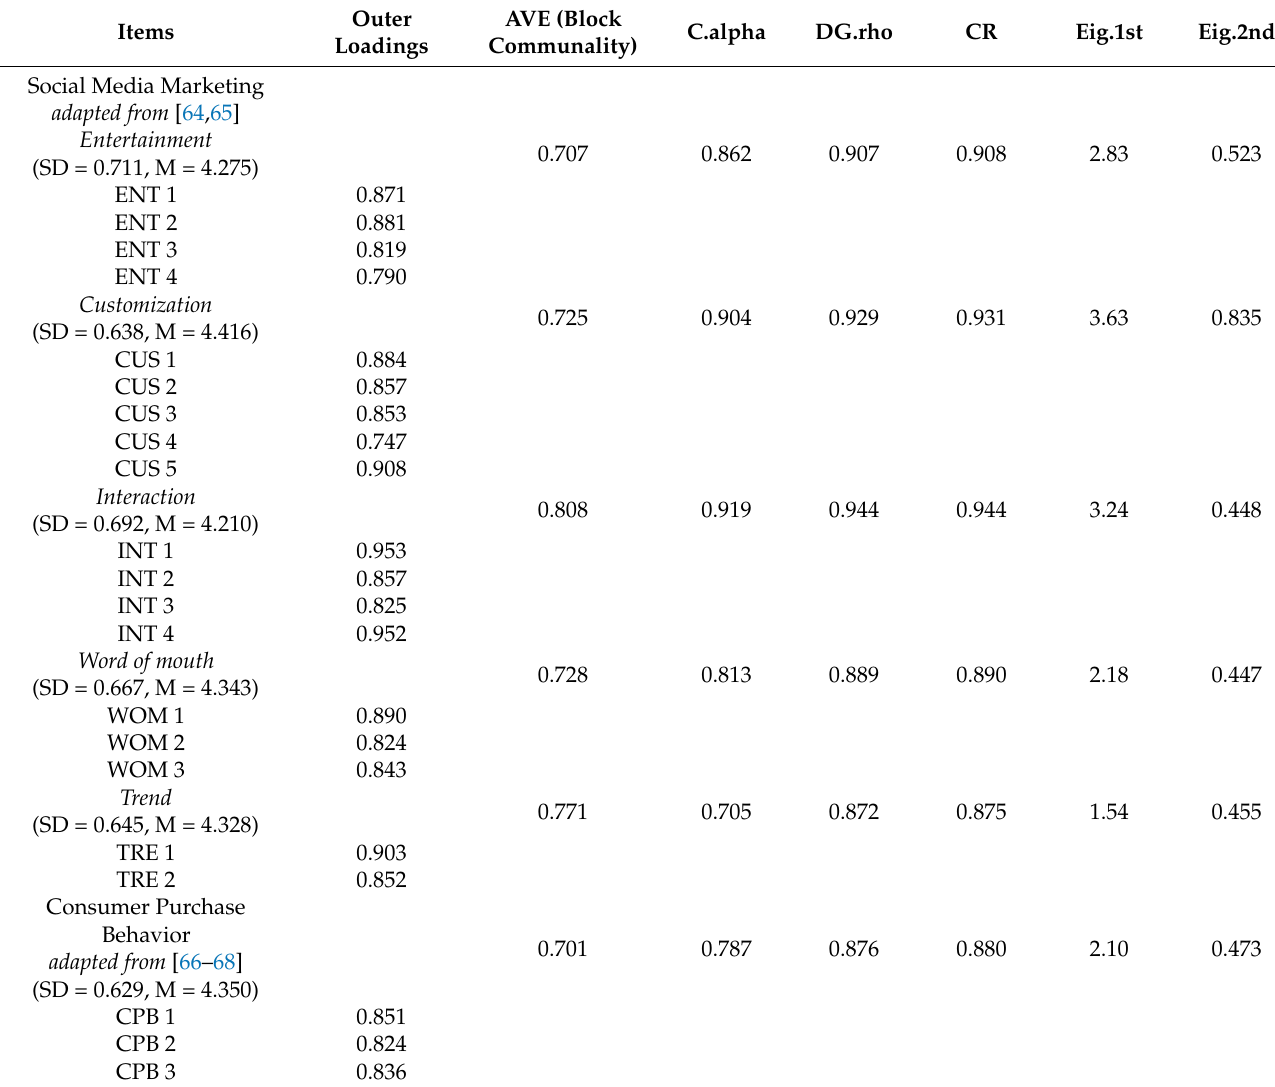
Table 2. Measurement models and measures.